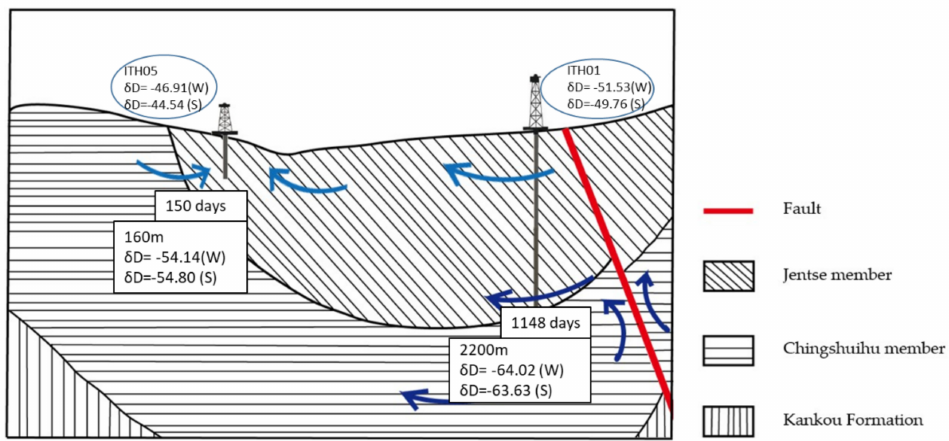
Figure 9. Based on combination of the temporal and spatial distributions of δ 18O and δ D values, local fault orientation, N30–70 ◦ E and a dip at 30–90 ◦ SE, and MRT estimation of two different depth of wells, ITH01 and ITH05, a local circulation conceptual model is built. W represents winter, and S represents summer. Squares represent thermal water while circles represent surface water. Lighter blue color arrows represent shallower groundwater while the dark blue arrows indicate deep circulation recharged from higher